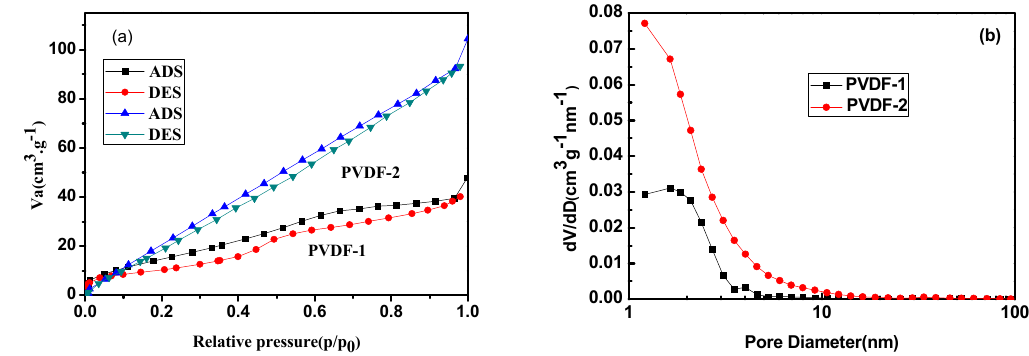
Figure 5. ( a ) Nitrogen adsorption–desorption isotherm, ( b ) pore size distribution plots of PVDF fiber membranes.